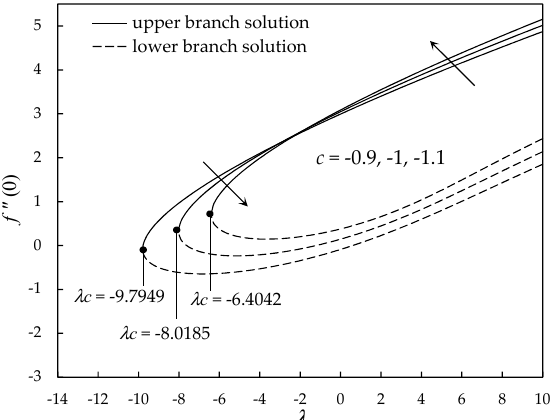
13 of 22 Figure 9. Variation of the reduced local Nusselt number −𝜃′(0) with the mixed convection parameter 𝜆 for various values of the suction parameter s when 𝜙 = 0.01, Nr = 0.1, K = 0.1 and c = − 1 for Cu- water nanofluid. Figures 10–13 are shown to present the impacts of stretching/shrinking parameter c on 𝑓 (cid:4593)(cid:4593) (0) and −𝜃′(0) . Notably, it is evident from these figures that 𝑓 (cid:4593)(cid:4593) (0) and −𝜃′(0) were higher in the